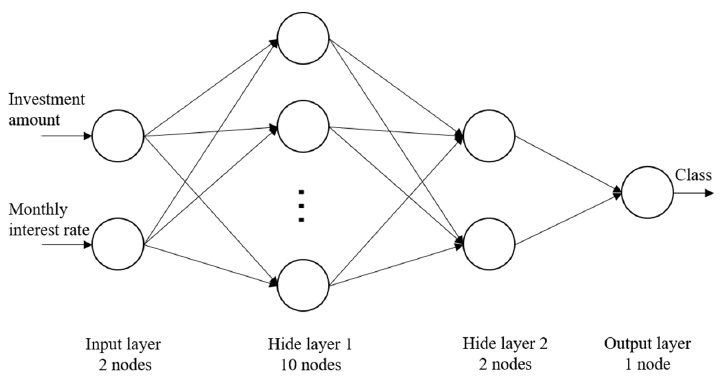
Figure 3. Structure diagram of the BP neural network.